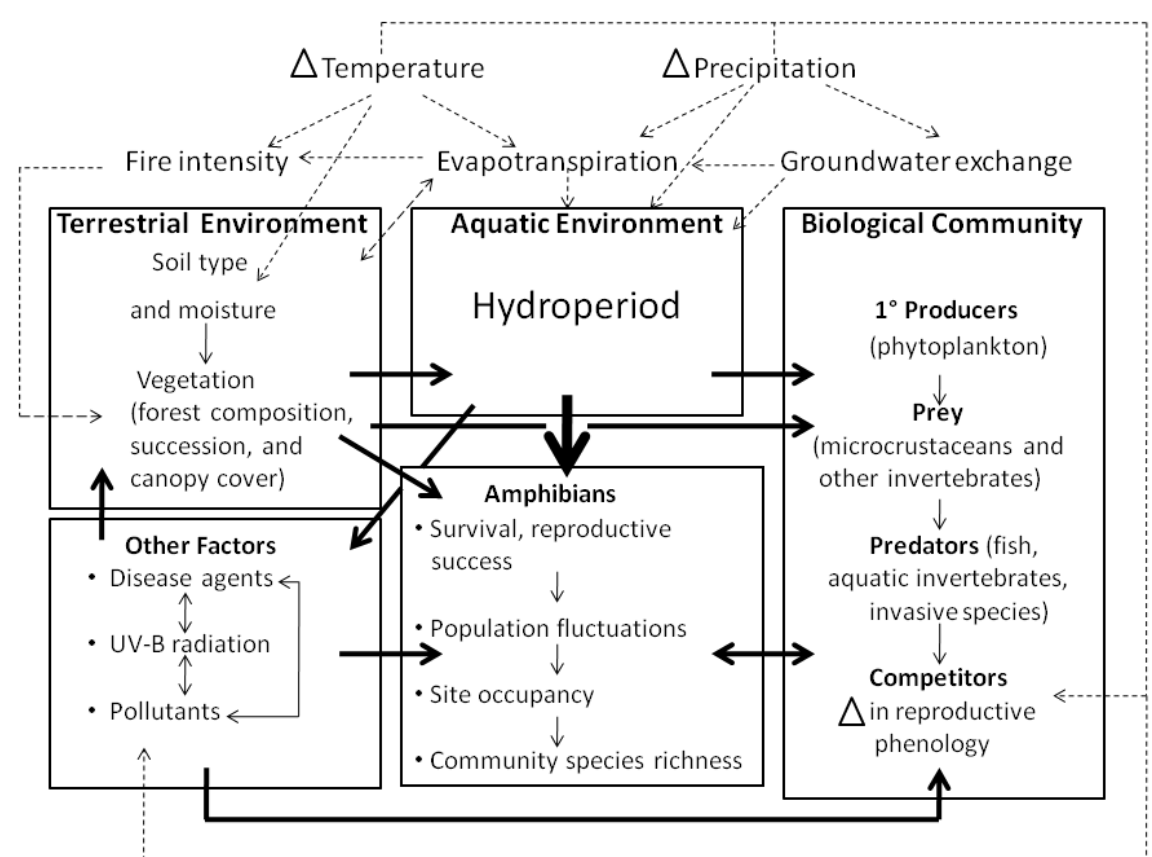
Figure 3. Conceptual model of pathways through which changes in temperature and precipitation may impact amphibian populations, using a generalized freshwater ecosystem as an example. Changes in temperature and precipitation affect amphibians via the effects of climate on terrestrial and aquatic habitats, the biological community in which amphibians are embedded and other factors such as disease agents, UV-B radiation and pollution. Factors that influence the availability of water, such as the hydroperiod of aquatic habitats, are likely the most important constraints on the reproductive success and persistence of amphibians (indicated by heavier arrow). Dashed arrows indicate interactions among meteorological variables, and their effects on biological communities and the environments in which they occur. Heavy solid arrows indicate relationships among compartments; light solid arrows indicate relationships within